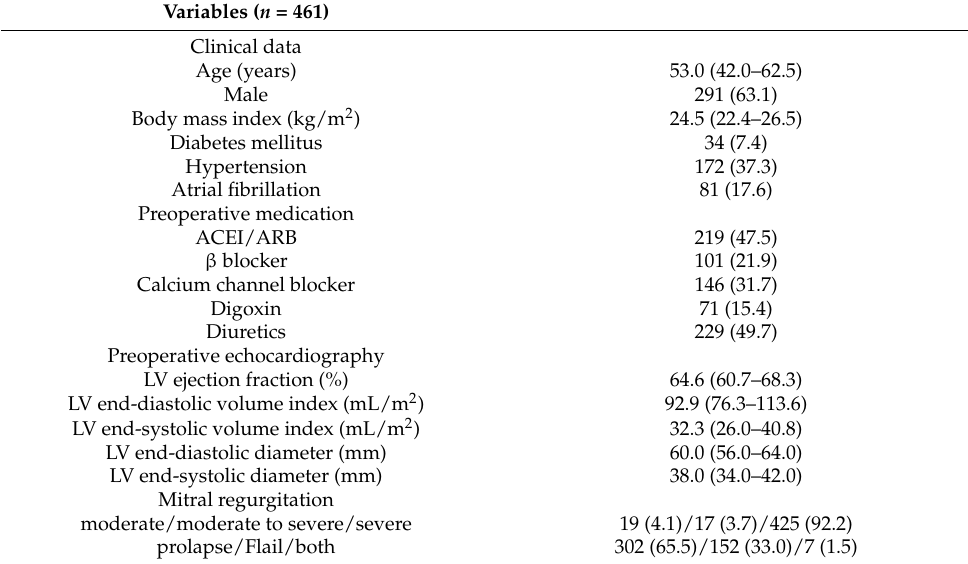
Table 1. Baseline patient characteristics and echocardiographic findings.